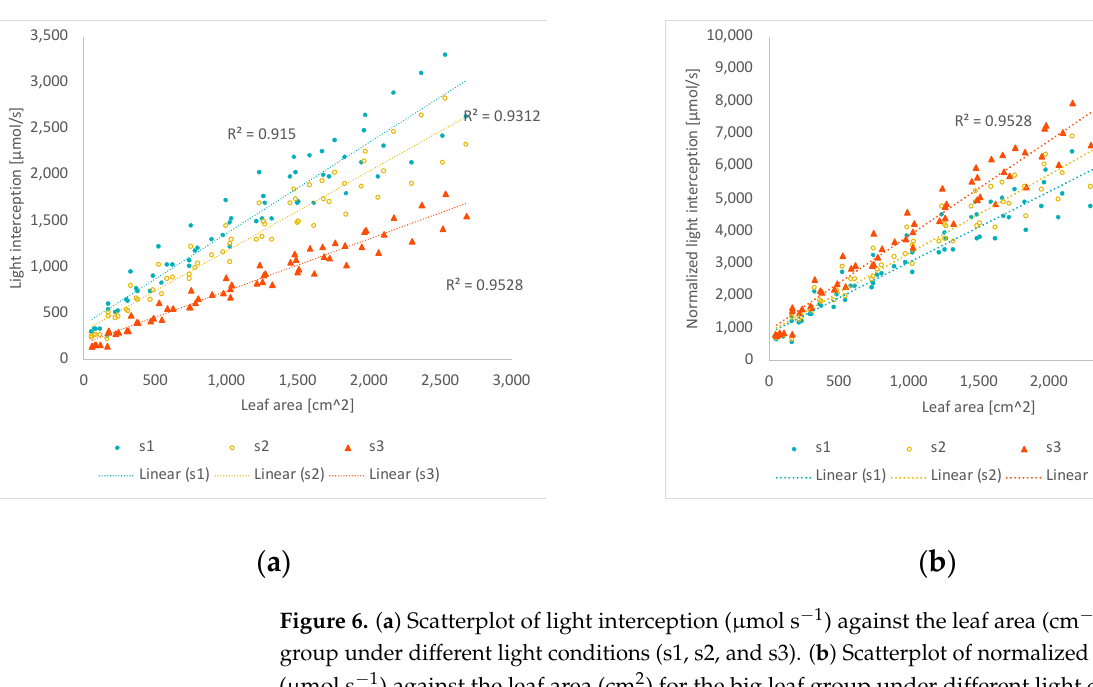
the incident radiation was normalized and lead to the linear relationships presented in Figure 6b. This relationship expressed the difference in light interception not only among the three scenarios (Figure 6a,b), but also among the canopies with different leaf sizes (Figure 7).